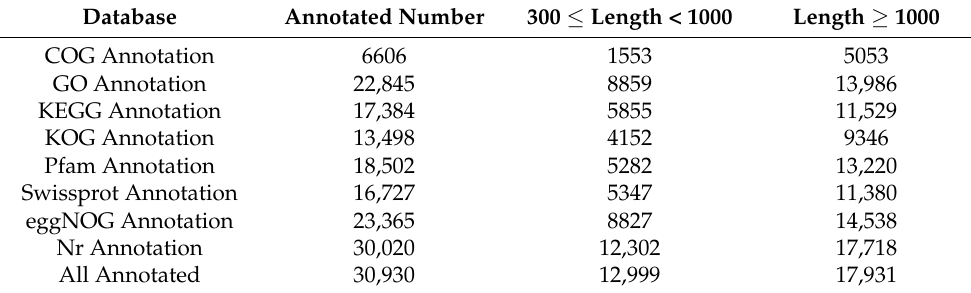
Table 2. Unigene annotation statistics.